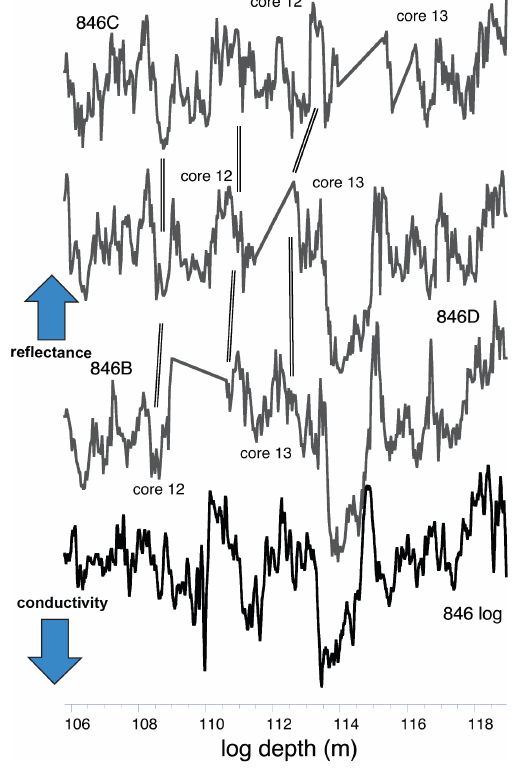
Figure 6. Detail of reflectance-based correlations (originally 122.6–137.8mc.d.) of offset holes 846B, 846C, and 846D corre- lated to the common depth scale of the borehole log (log depth 106– 119m). Signals were detrended and normalized; higher reflectance and lower-conductivity plot upward. Note the problematic tie of the base of Hole 846C, core 12, to the top of Hole 846D, core 13 (ship- board splice). In contrast, Hole 846B has a sequence that correlates easily to the borehole log and can be reliably spliced to the base of Hole 846D, core 12.